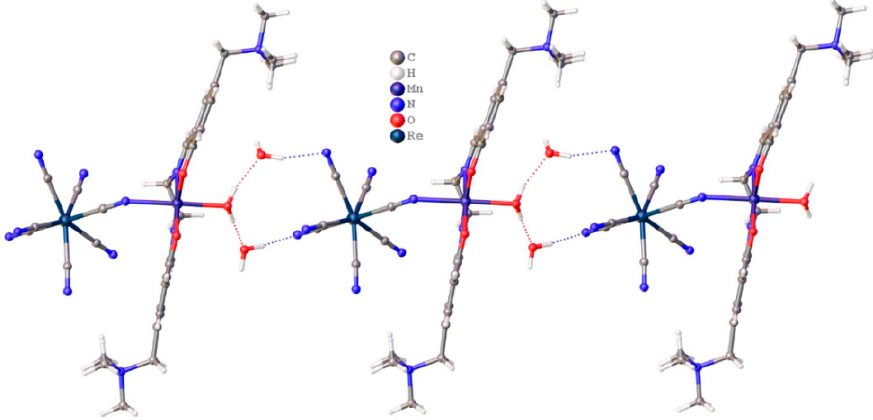
Figure 13. The 1D motif formation in 13 . A view along the b axis [46].